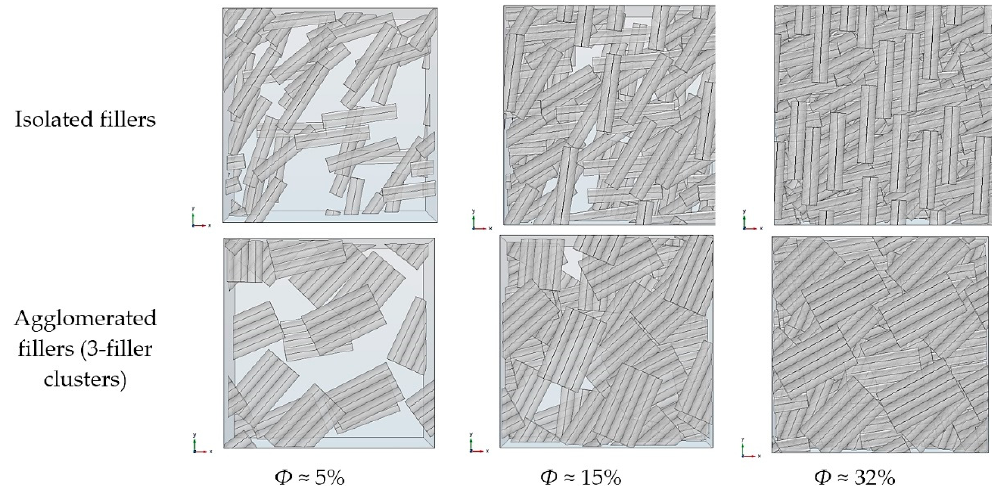
Figure 9. Projected view in the overall diffusion direction z of generated RVEs for isolated fillers and 3-filler clusters (agglomerated) for several volume fraction values.